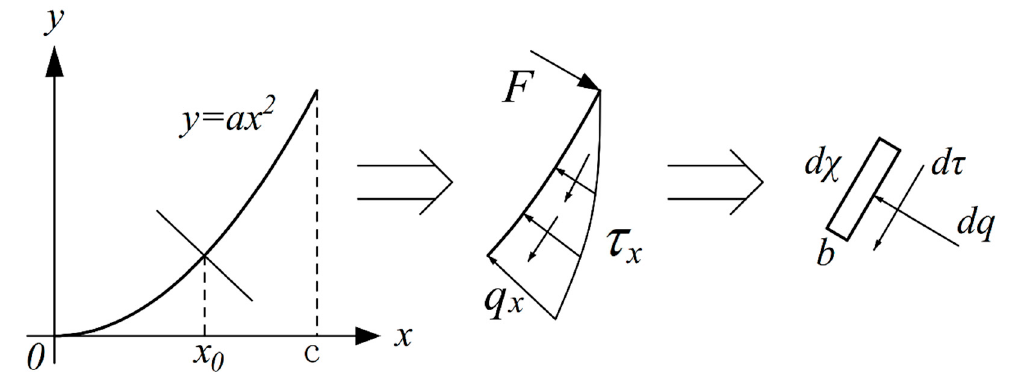
Figure 5. Schematic diagram of the force calculation of the micro element.